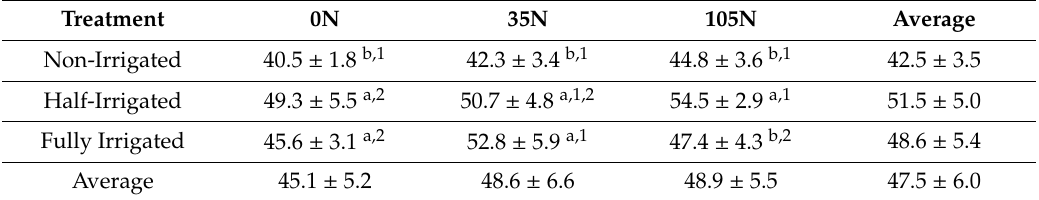
Table 13. The e ff ect of di ff erent fertilization rates on pod number per plant of soybean (cv. Pannonia Kincse) under di ff erent irrigation regimes, averaged among 2017, 2018, and 2019 in Debrecen,